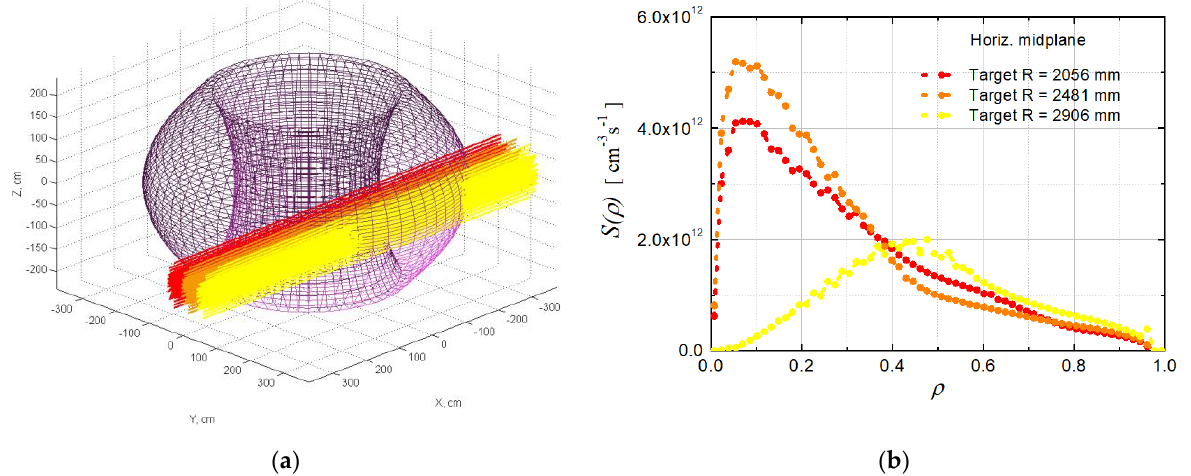
Figure 9. (a) Approximation of finite width neutral beams by a large number of mathematical lines. The central injection lines correspond to those shown in Figure 6 (a); (b) Source functions of fast ions produced by neutral beams depicted by the corresponding colours.